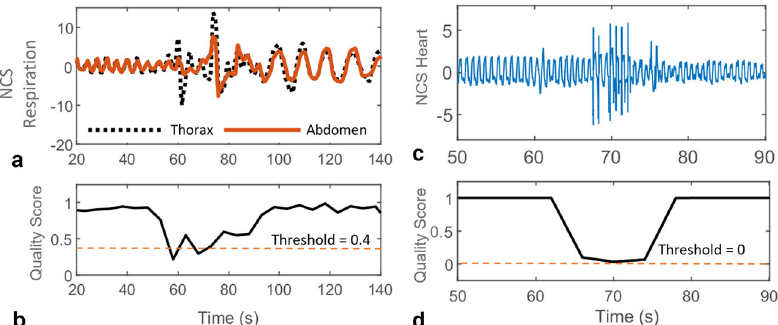
Fig. 5 The quality score for respiration and heartbeat waveforms with motion artifact instance between 60 – 80 s. A fi xed, empirically selected threshold is used to reject poor data, given by a low quality score. a Normalized NCS thorax and abdomen respiration waveforms. b Respiration quality score in the range [0,1], showing poor quality with a score less than the threshold (0.4). c Normalized fi ltered NCS heartbeat waveform modulated on the thorax sensor, with most of the artifact fi ltered out. d Quality score normalized by tanh ðÞ in the range [ − 1, + 1]. A low threshold of 0 is selected, as the second-harmonic method used for heart rate estimate provides even higher motion